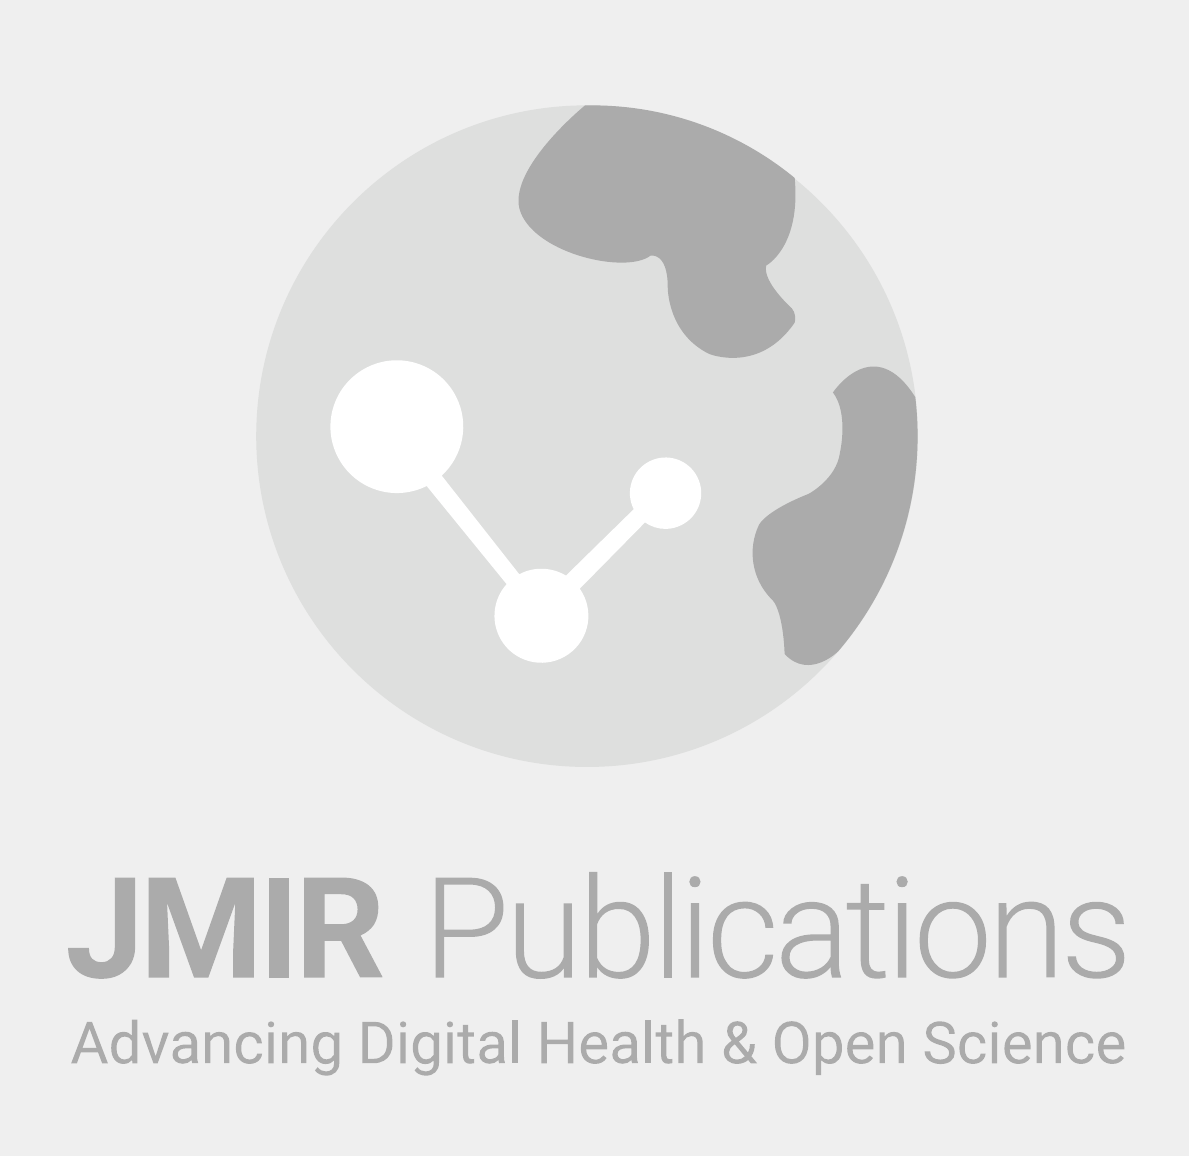
Figure 1. Preferred Reporting Items for Systematic Reviews and Meta-Analyses (PRISMA) flow